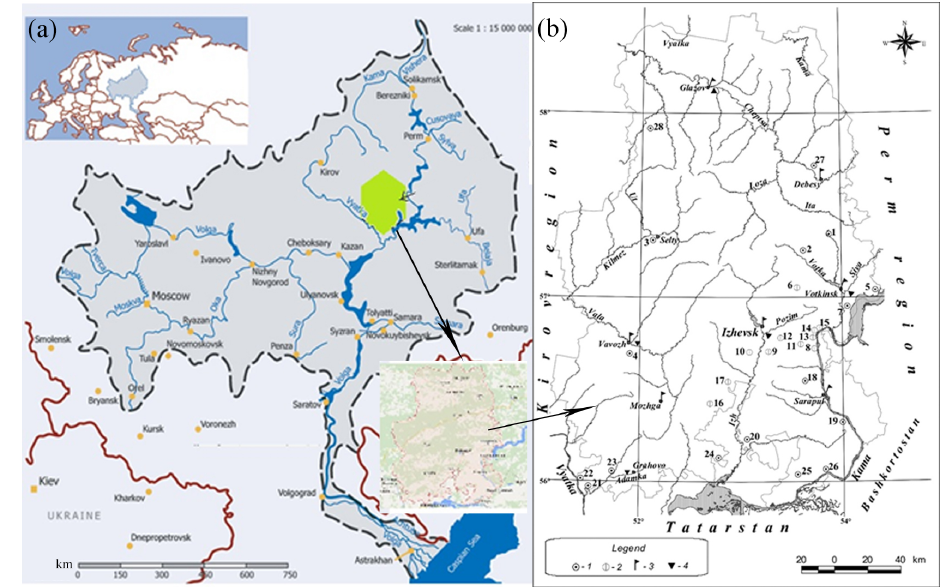
Figure 1. Map of the Volga River basin showing the location of the Vyatka-Kama interfluve (a) and Udmurt republic (b) . (Legend: 1 – study sites with annual measurement of gully head retreat, 2 – study sites with measurement of gully head retreat twice per year (after